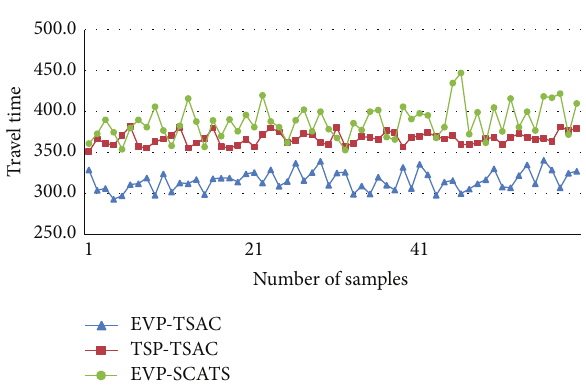
Figure 9: Transit travel time with 𝑉/𝐶 > 1.0 for different traffic signal control